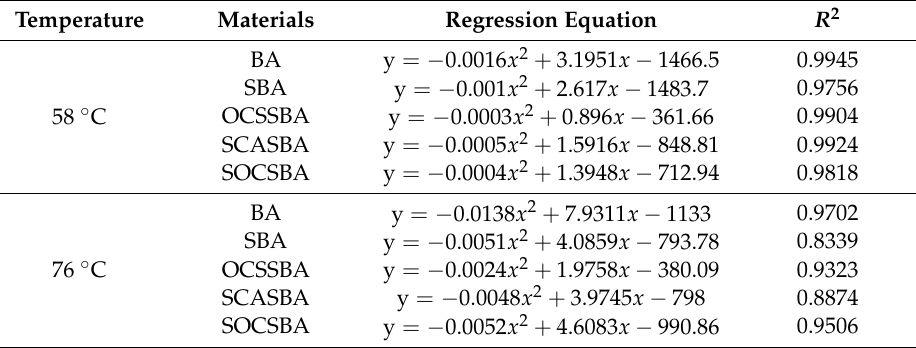
Table 7. Regression equation of the Cole-Cole curve of five asphalt binders at 58 ◦ C and 76 ◦ C.